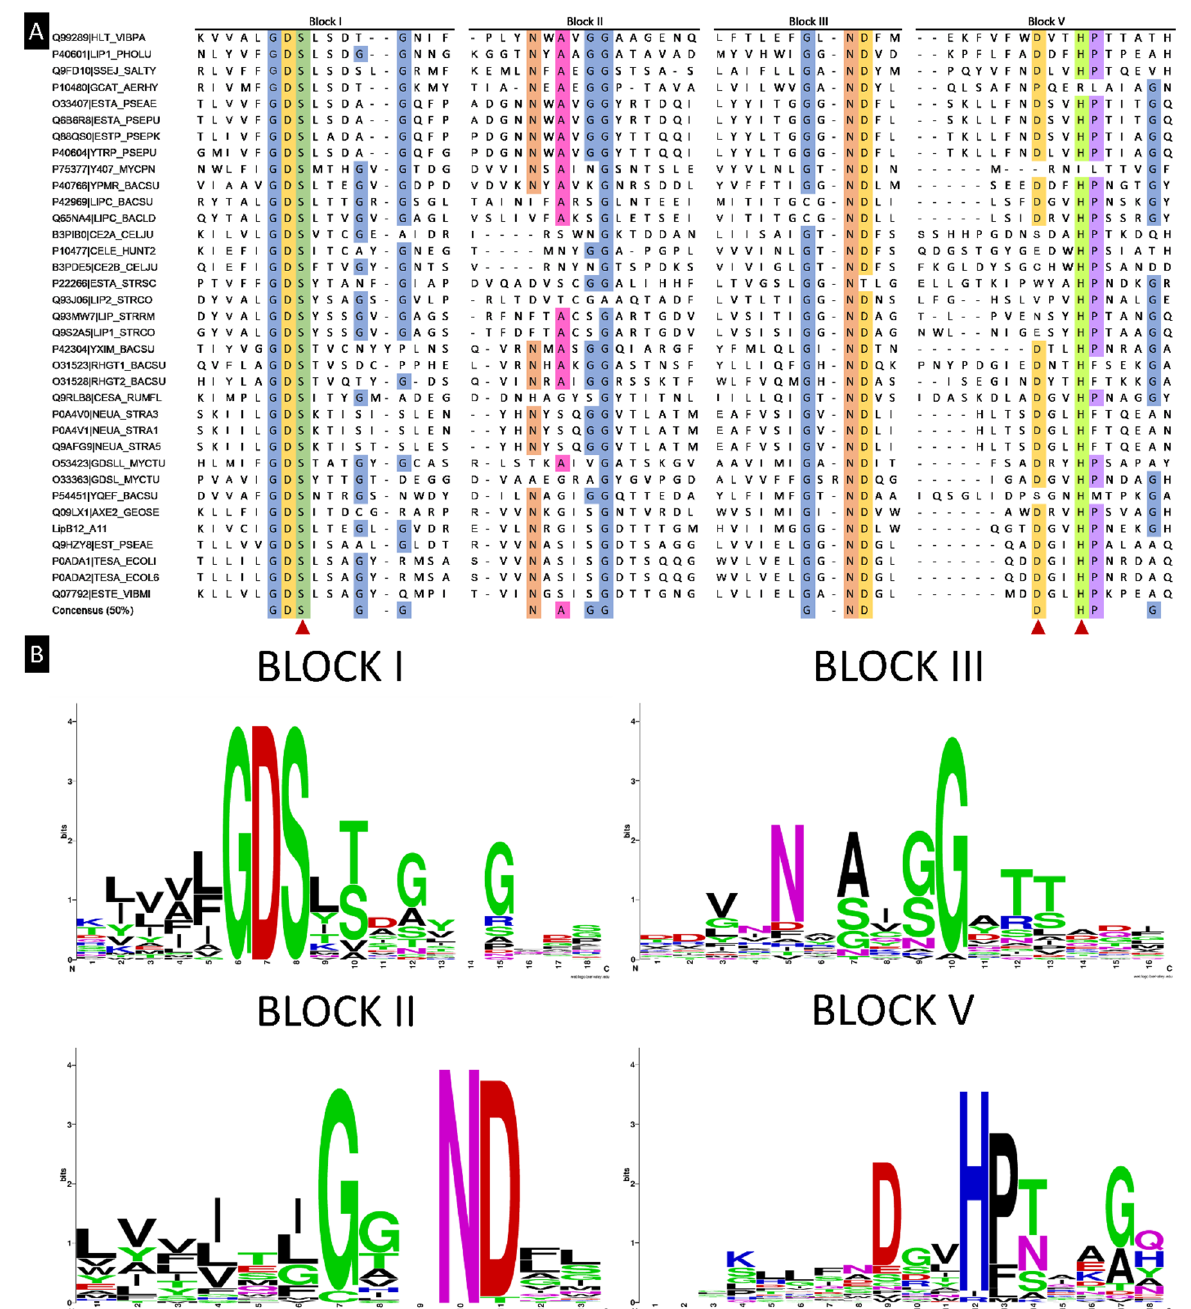
Figure 3. LipB12_A11 sequence analysis. ( A ) Multiple sequence alignment of GDSL family lipases of bacterial origin reviewed and deposited in the UniProt database, including the lipolytic activity enzyme found in this work. Four conserved blocks are represented. A consensus sequence of at least 50% conserved residues among all sequences is given, and the three residues from the catalytic triad are highlighted. ( B ) Protein web logos resulting from the alignments of the amino acids from the four blocks.